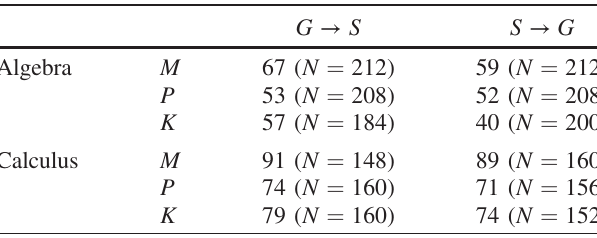
TABLE I. Percentage of correct answers per context and translation. N is the number of student answers per item type (given in brackets).